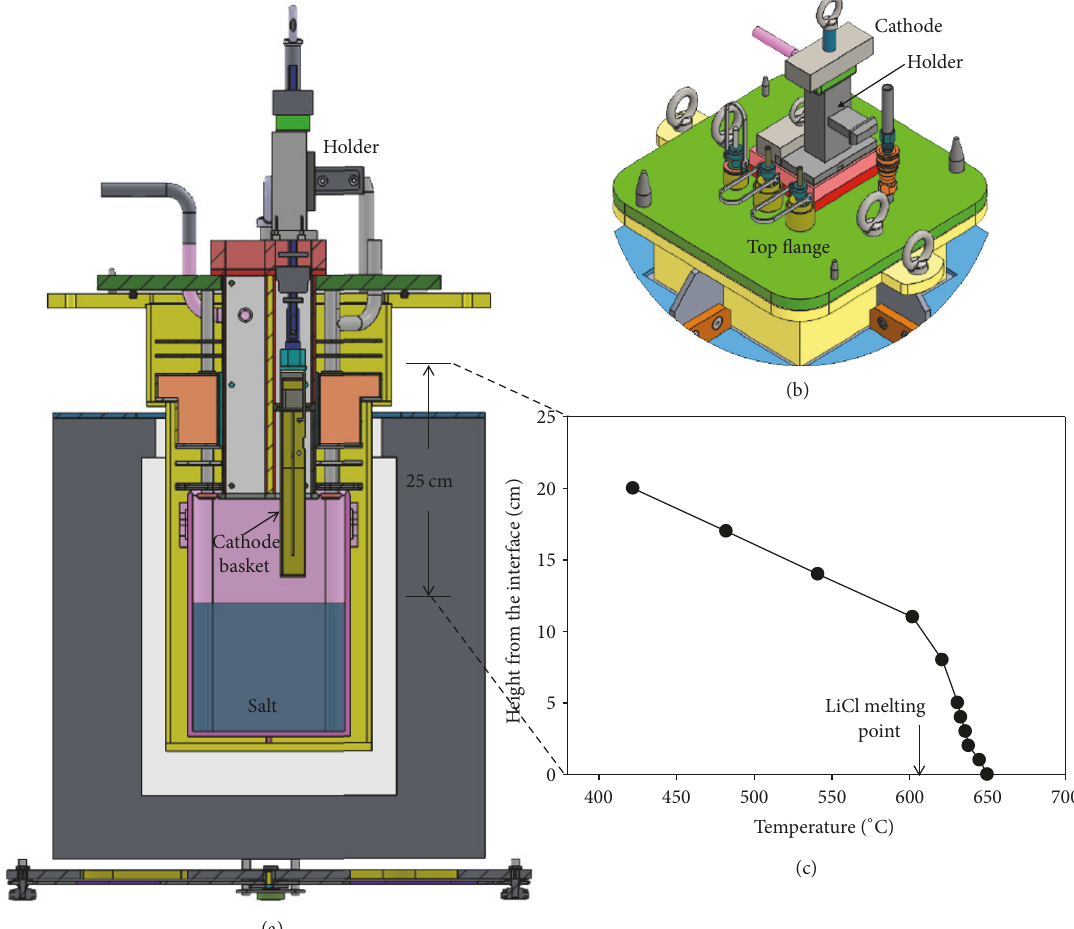
Figure 4: The salt draining process of the cathode basket after the OR: drawing of (a) the side view, (b) the top view, and (c) the vertical temperature distribution around the cathode